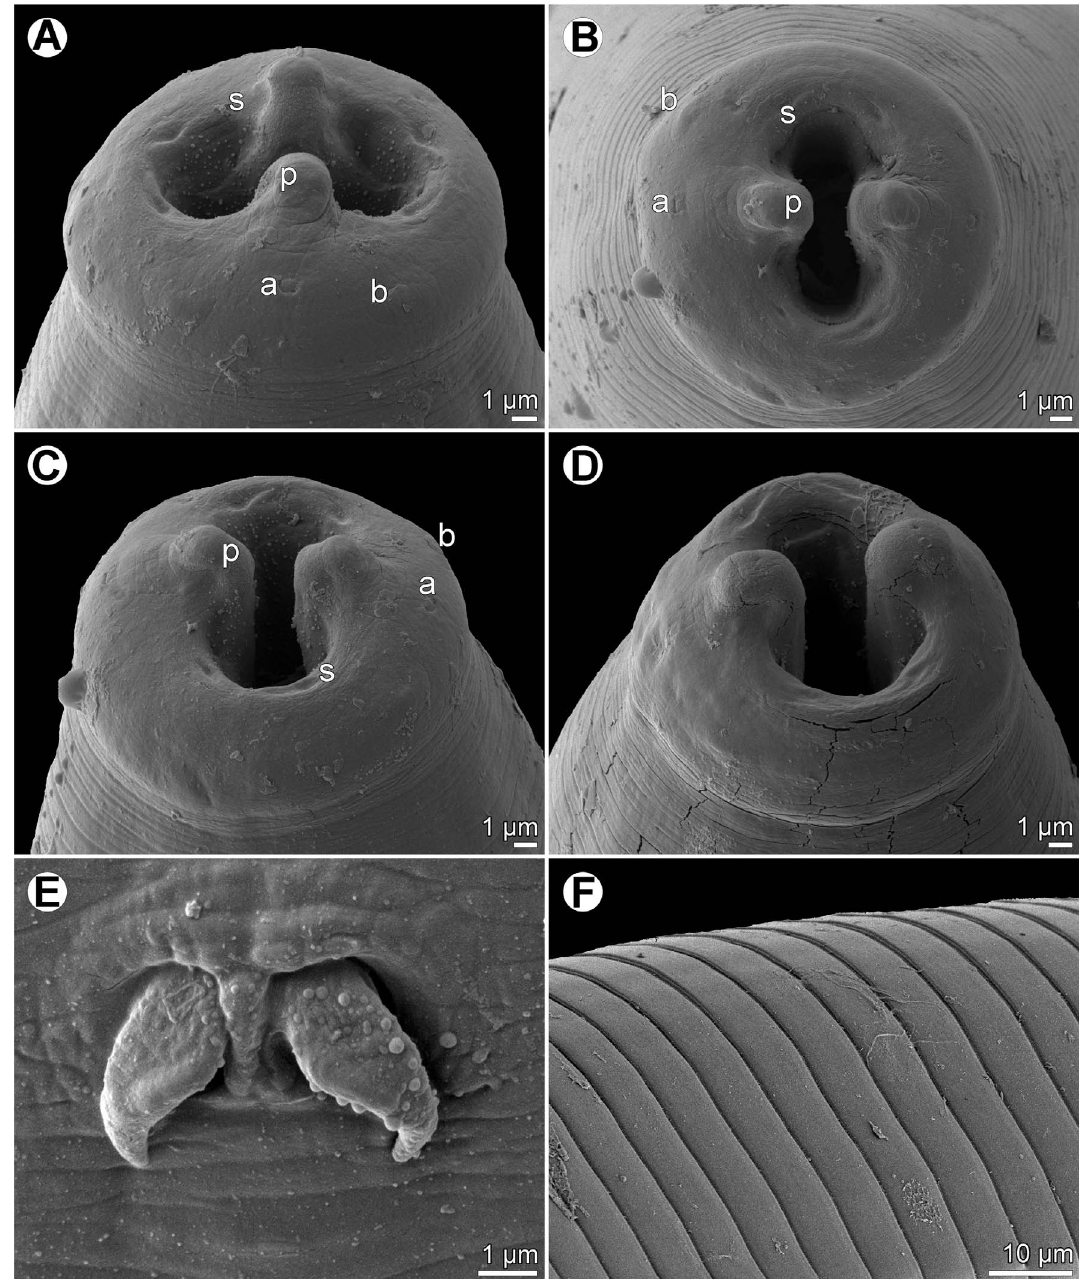
Figure 5. Ascarophis ( Ascarophis ) nasonis Machida, 1981 from Naso spp., scanning electron micrographs. (A, B) Cephalic end, lateral and apical views, respectively; (C, D) cephalic end, dorsoventral views (two different specimens); (E) deirid; (F) detail of cuticle at middle part of body. (a) Amphid; (b) cephalic papilla; (p) pseudolabium; (s)